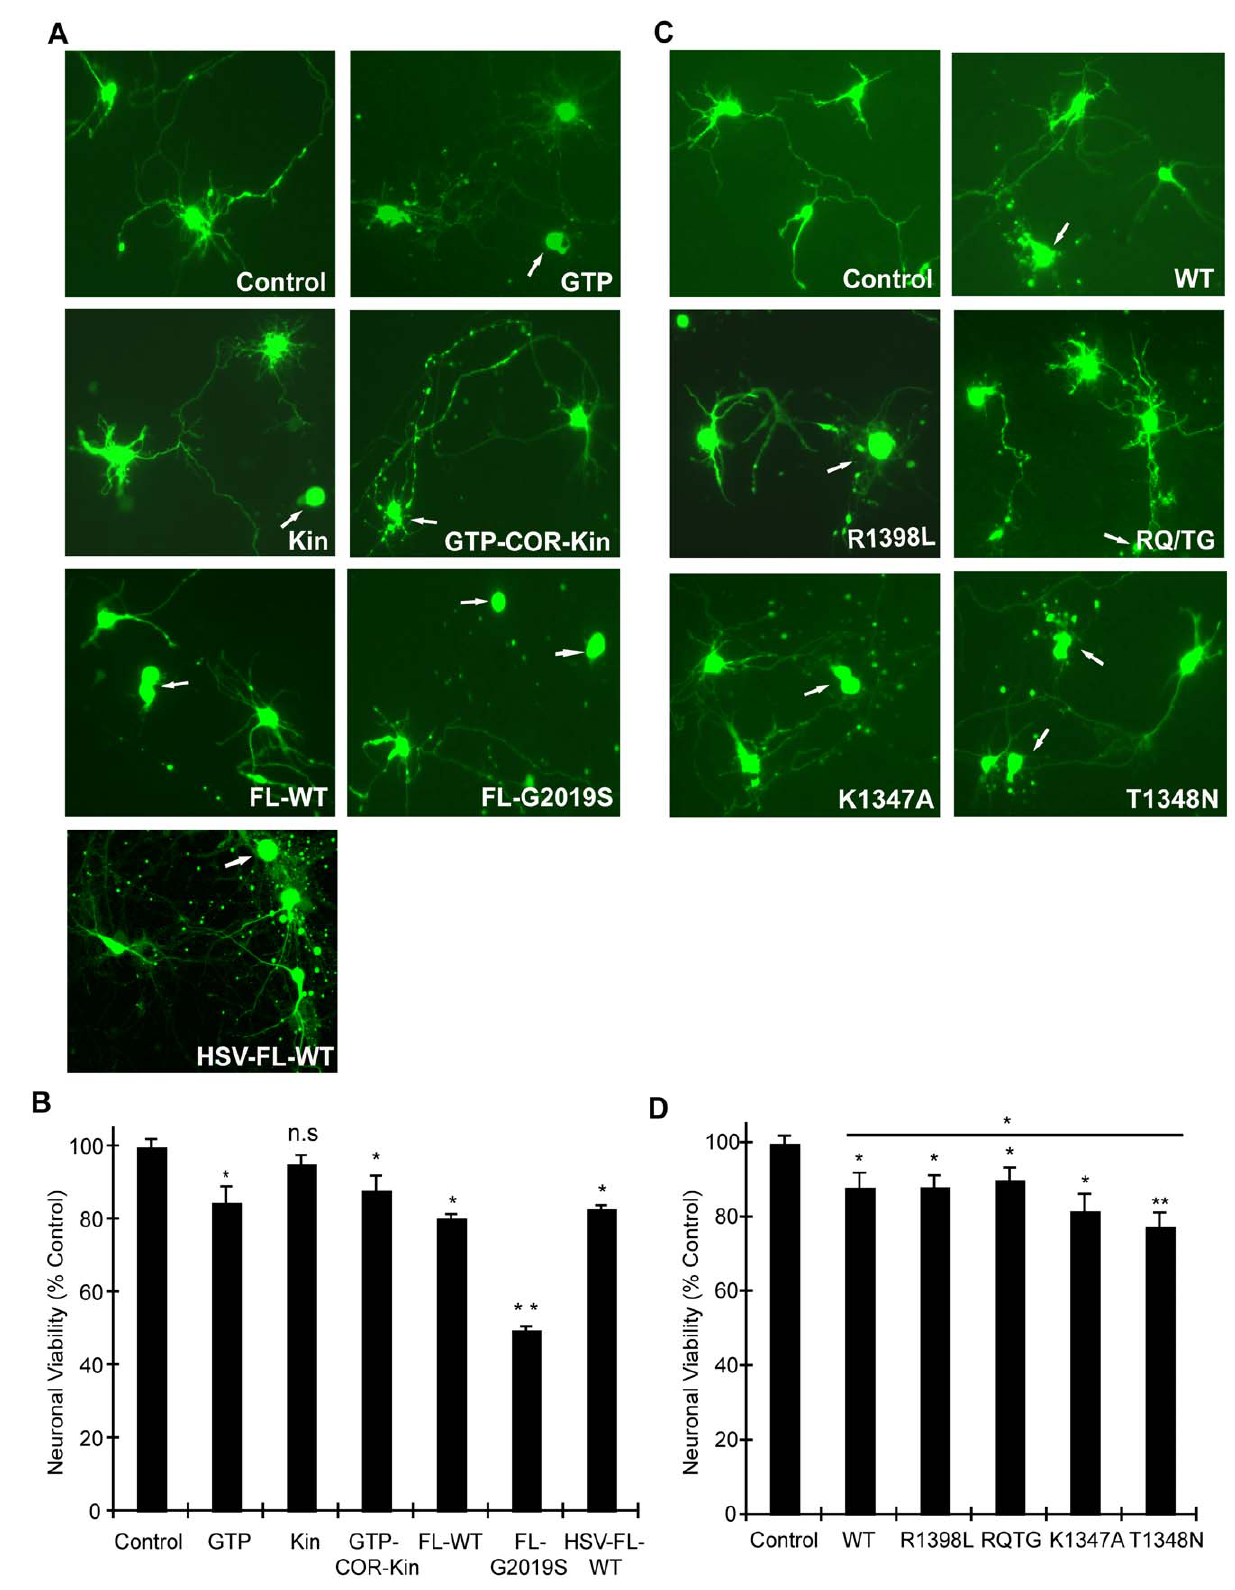
Figure 5. GTPase activity modulates LRRK2-induced neuronal toxicity. (A) Human LRRK2 domain fragments containing the GTPase domain (GTP and GTP-COR-Kin) but not the kinase domain (Kin) alone induce neuronal toxicity similar to full-length WT LRRK2. Representative fluorescent images (eGFP) showing mouse primary cortical neurons co-transfected with LRRK2 constructs and eGFP in a 10:1 molar ratio or transduced with